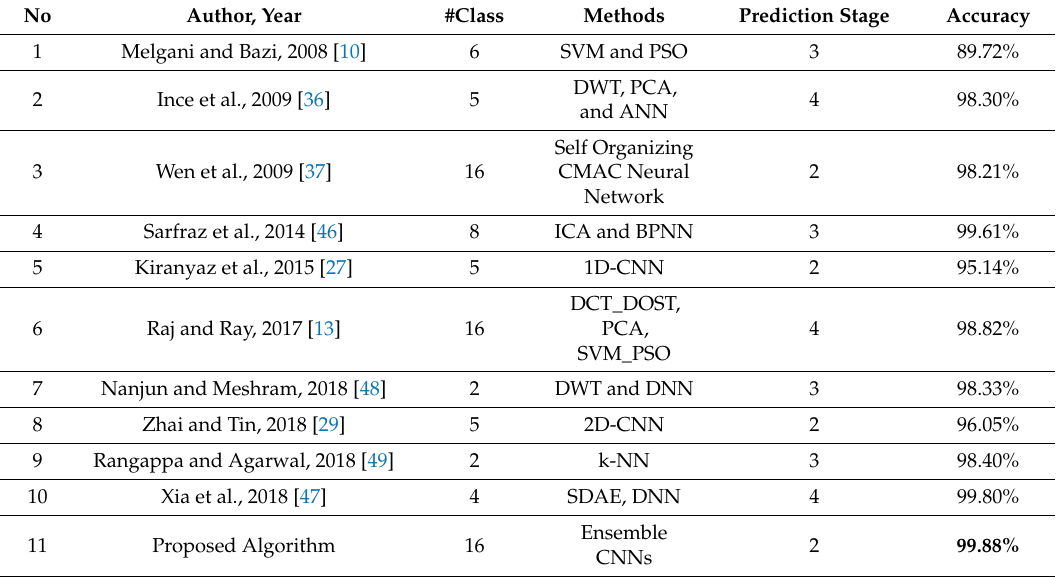
Table 8. Benchmarking of the proposed algorithm with other algorithms using MIT-BIH